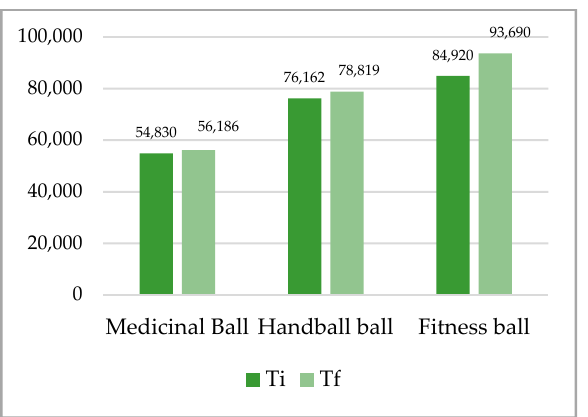
Figure 4. Mean of plank up test with 2 support points (arms, legs)—team sports.